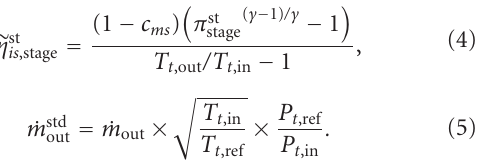
(vi) a removal of 0,1 percent of the experimental surge massflow through a smaller suction slot, so that the slot surface massflow is the same as the case of 0,3% hub suction.